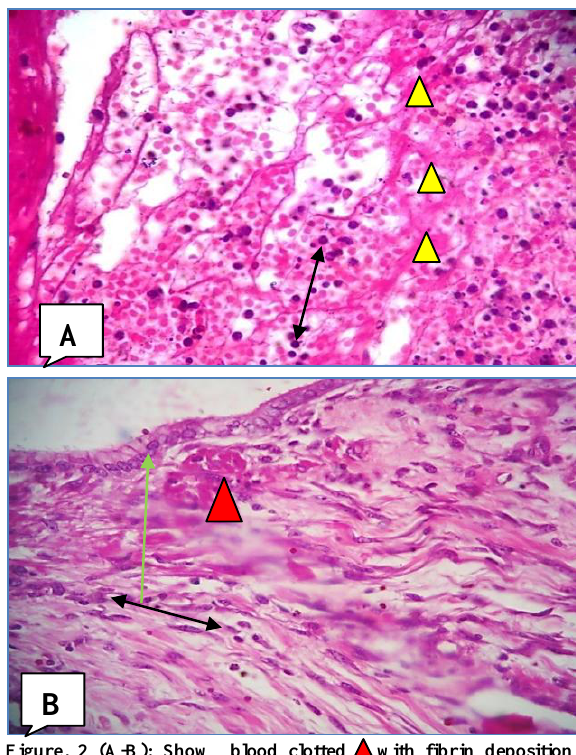
Figure, 2 (A-B): Show blood clotted with fibrin deposition hhhhtogether with PMN leukocytes infiltration re- epithelialization of insicional margin by thin layer of columnar epithelial sutured by extra-mucosal pattern, three days post operation (H and E., 40X).